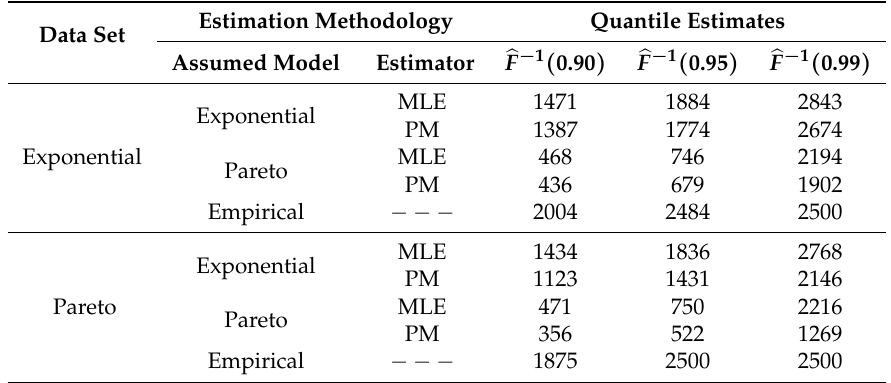
Table 3. Parametric and empirical estimates of the 90%, 95% and 99% quantiles for the exponential and Pareto data sets of Table 1.